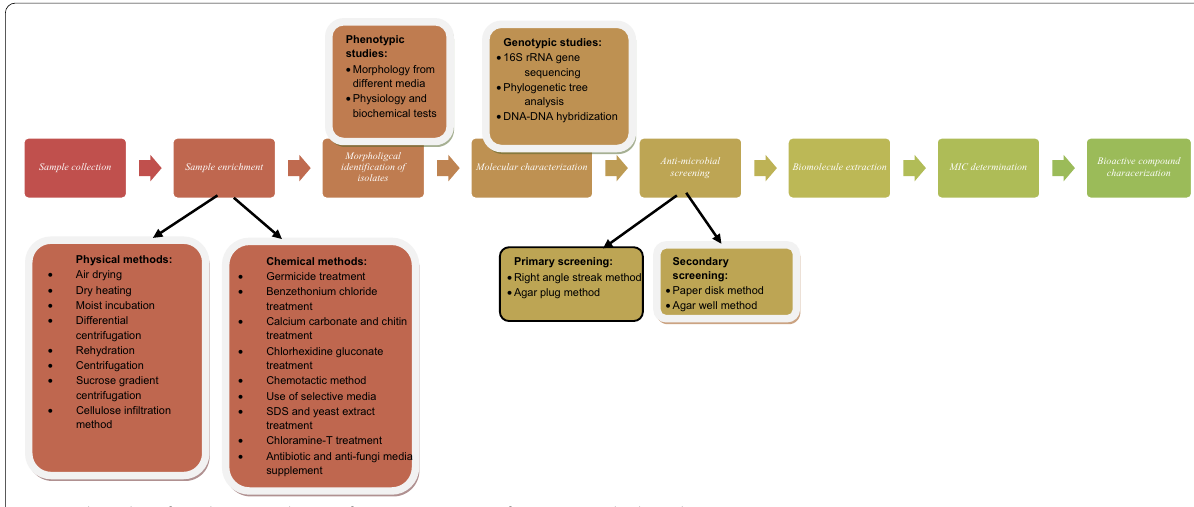
Fig. 2 Flow chart for selective isolation of rare actinomycete for anti-microbial